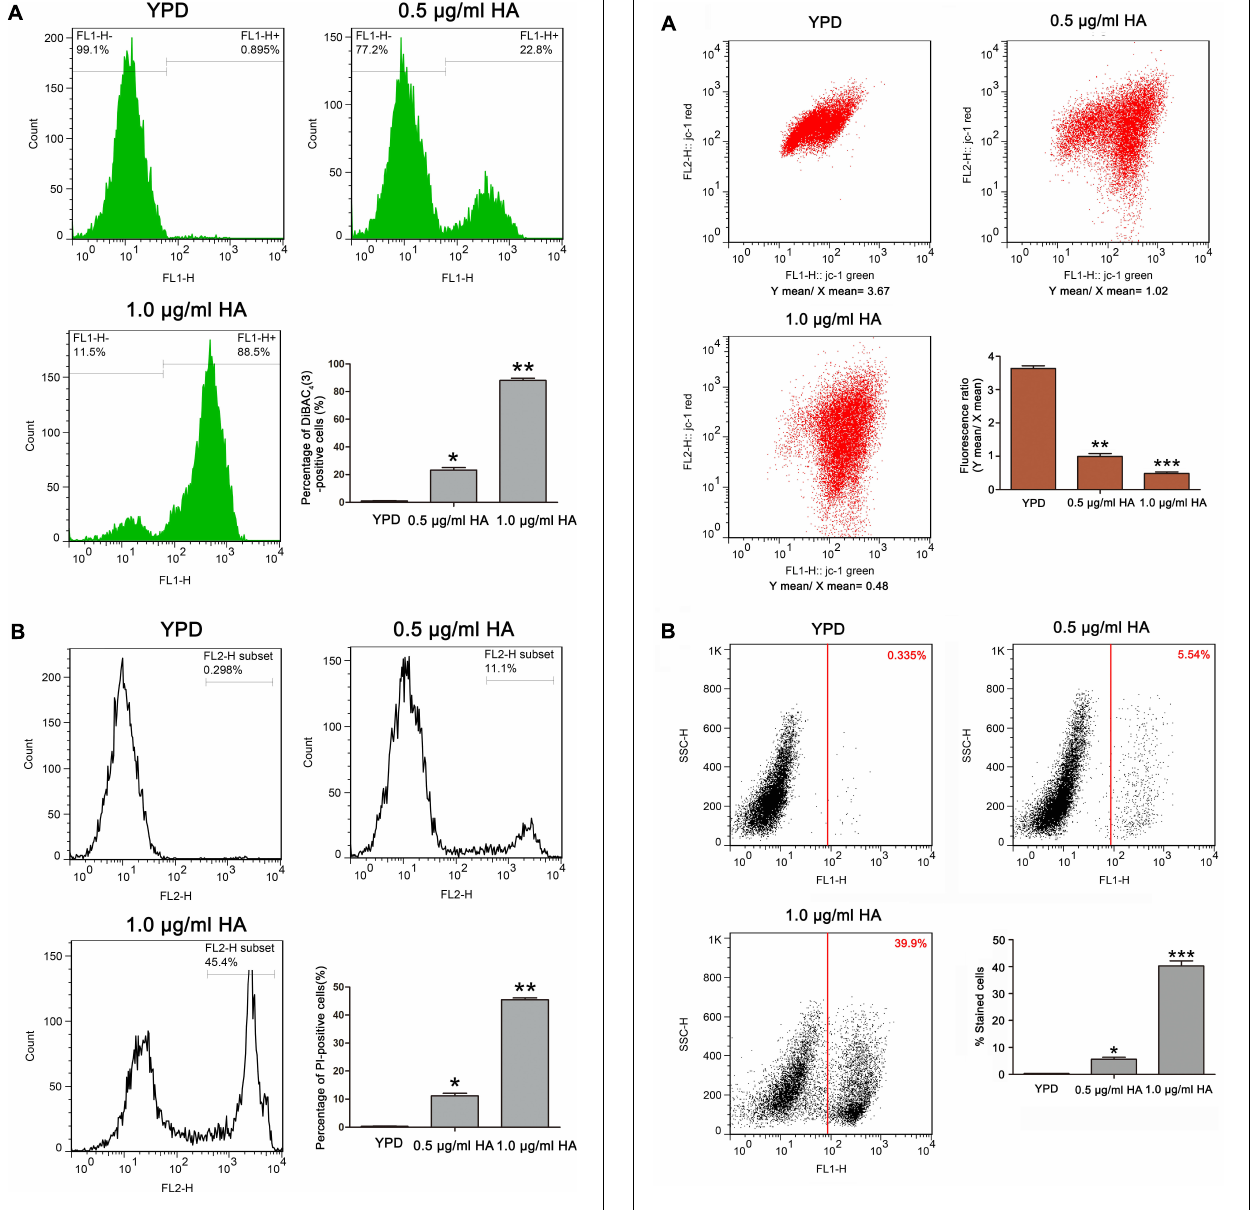
FIGURE 3 | Effect of HA treatment on cell membrane in C. albicans cells. (A) The changes of cell membrane potential were assessed in HA-treated C. albicans cells using DiBAC 4 (3) staining. The histogram was the quantitative analysis of DiBAC 4 (3)-positive cells, and data were exhibited as mean ± SD ( n = 3). ∗ P < 0.05 and ∗∗ P < 0.01. (B) Cell membrane integrity was evaluated using PI staining. The percentage of PI-positive cells was displayed in the histogram, and data were shown mean ± SD ( n = 3). ∗ P < 0.05 and ∗∗ P < 0.01.